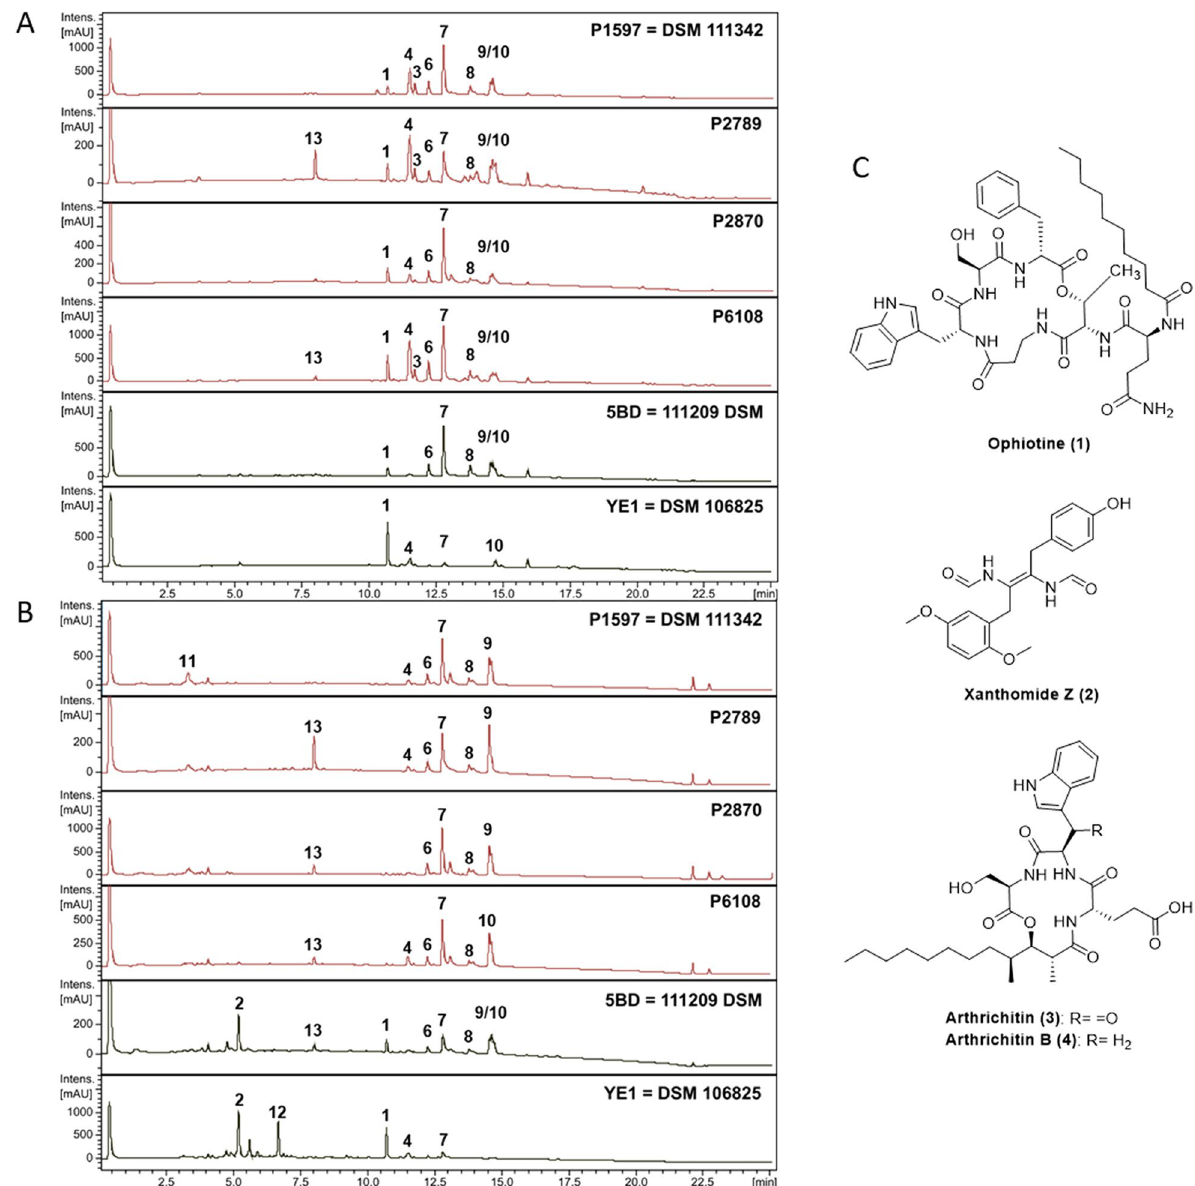
Fig. 2 Comparison of HPLC–DAD/MS profiles of strains cultivated in ZM/2 media. Relative absorbance at 210 nm is shown. a Crude extracts from mycelia. b Crude extracts from supernatant. Crude extracts form plant‑associated and nematode‑associated strains are indicated in red and black, respectively. c Secondary metabolites ( 1–4 ) described by Helaly et al. (2018a) produced in ZM/2 media by the strain DSM